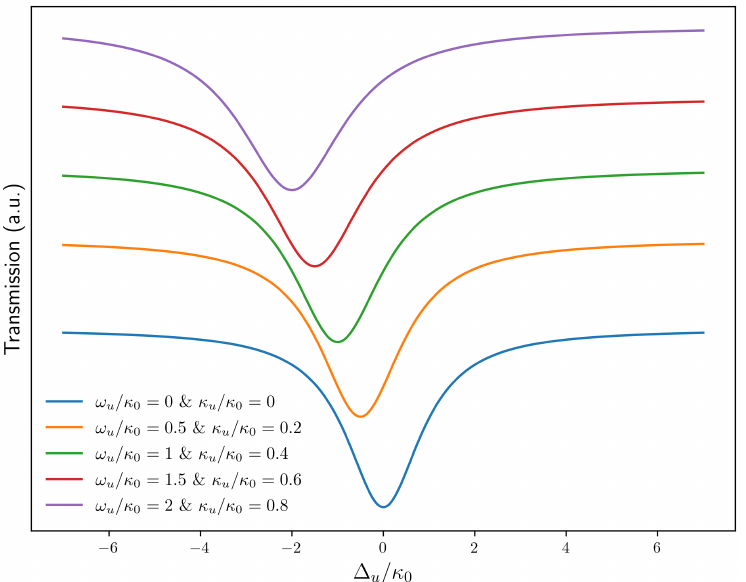
Figure 3. The numerical simulation of the changing of the transmission spectrum of the system in the presence of